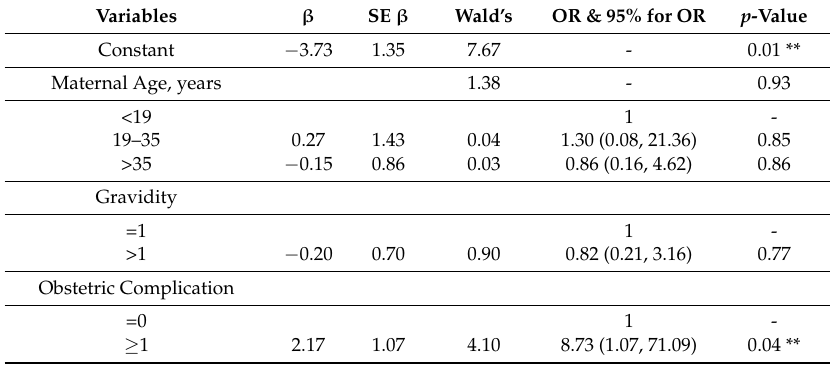
Table 6. Multivariate binary logistic regression output for maternal